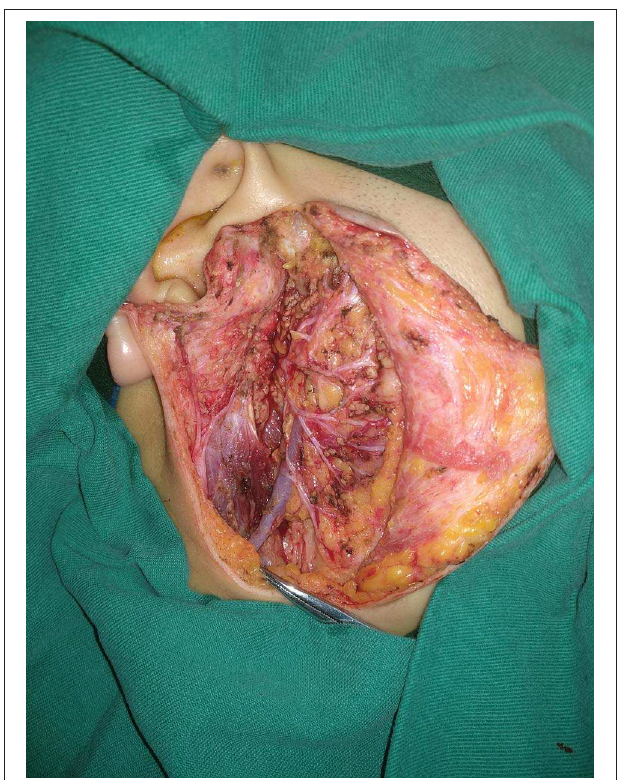
FIGURE 1 | Superficial parotidectomy in a pediatric